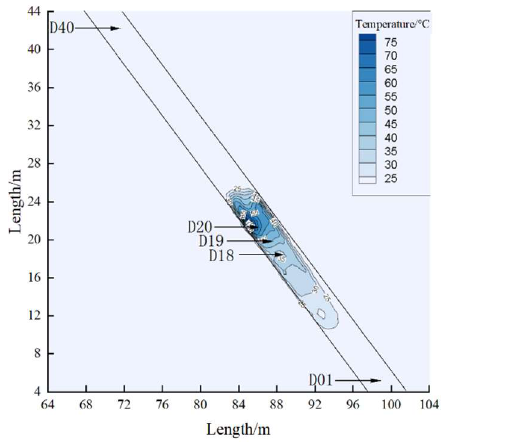
Figure 4. Temperature change chart of the diagonal branch at different times.